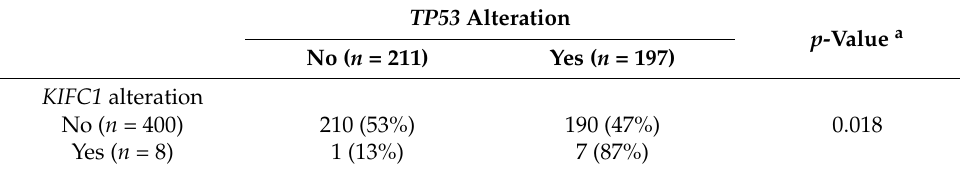
Table 5. Relationship between KIFC1 and TP53 gene status in gene alterations in the TCGA BLCA.